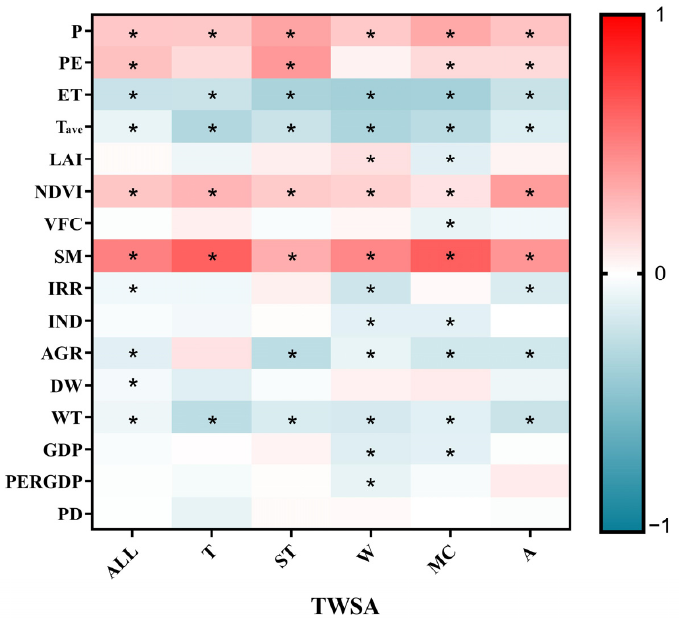
Figure 7. The partial correlations between TWSAs and their driving factors. T, ST, W, MC, and A represent tropical monsoon, subtropical monsoon, warm temperate, mild-cold temperate, and alpine climate zones, respectively. (* Significant at α = 0.05).